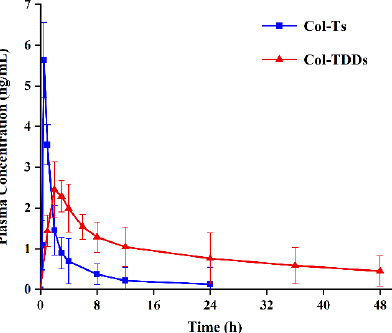
Figure 4. Plasma concentration-time profiles of colchicine in rats after transdermal patch (6.4